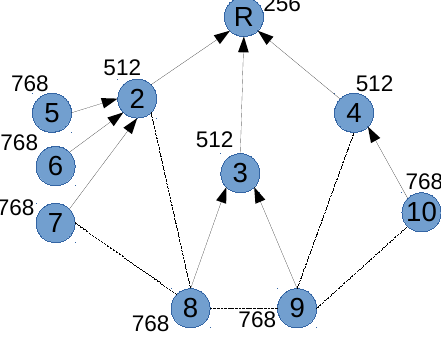
Figure 1. Example of RPL